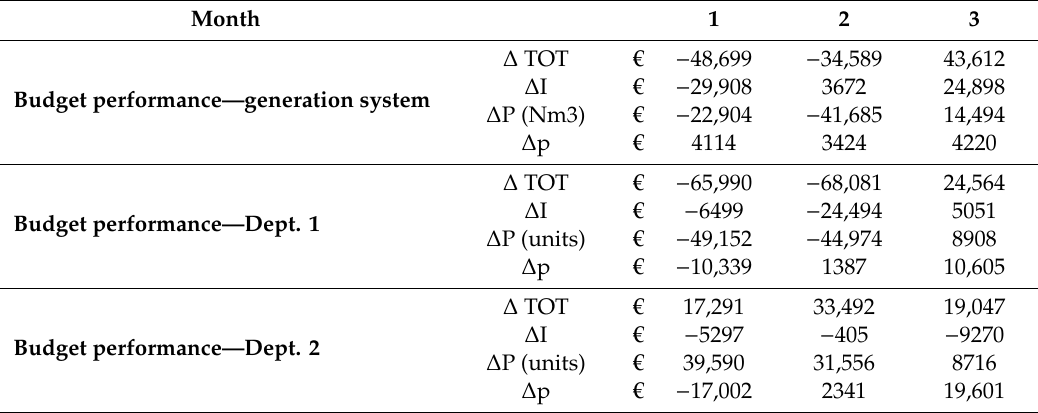
Table 6. Budget variance analysis for the considered